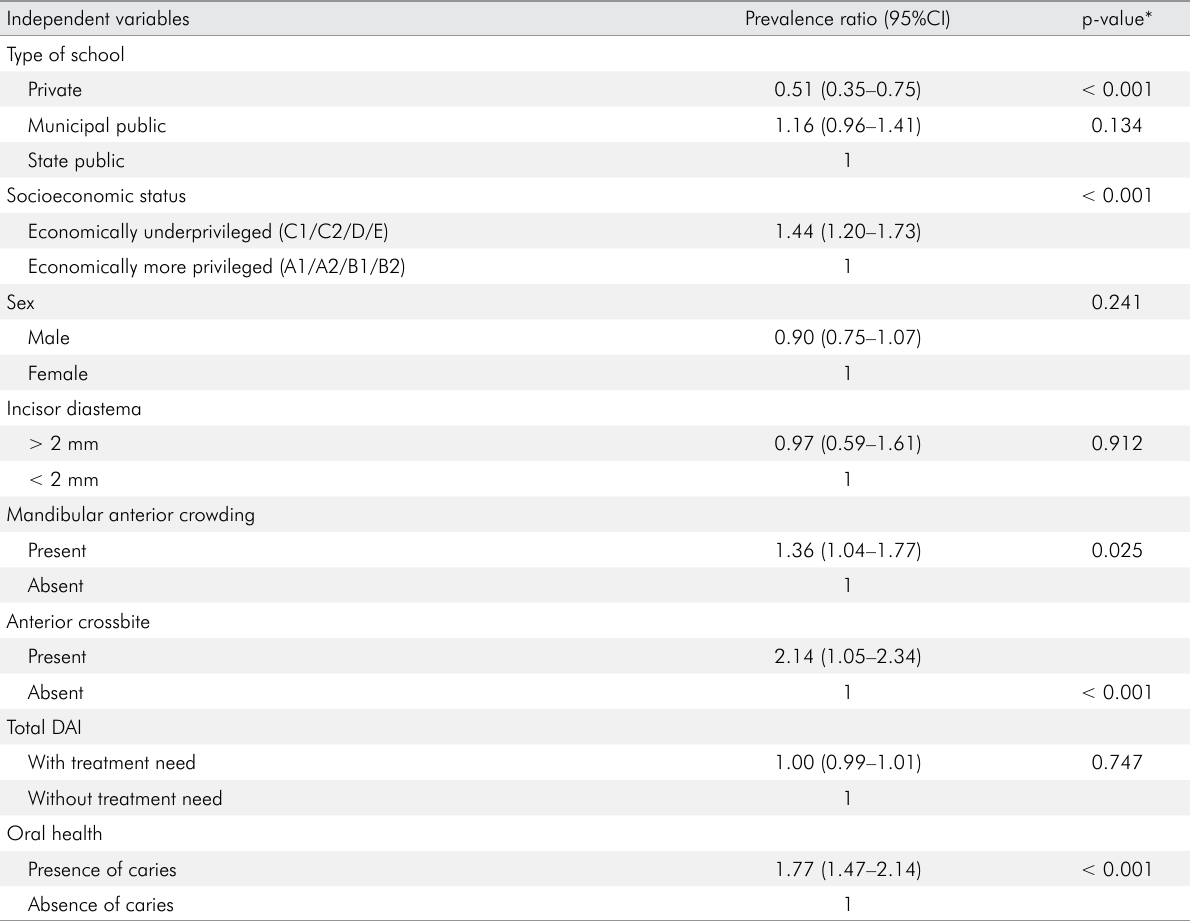
) independent variables (n = 390); Diamantina, Brazil, 2013. (8-10)